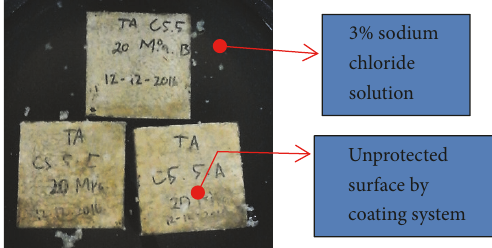
Figure 3: The process of soaking the specimen using 3% sodium chloride